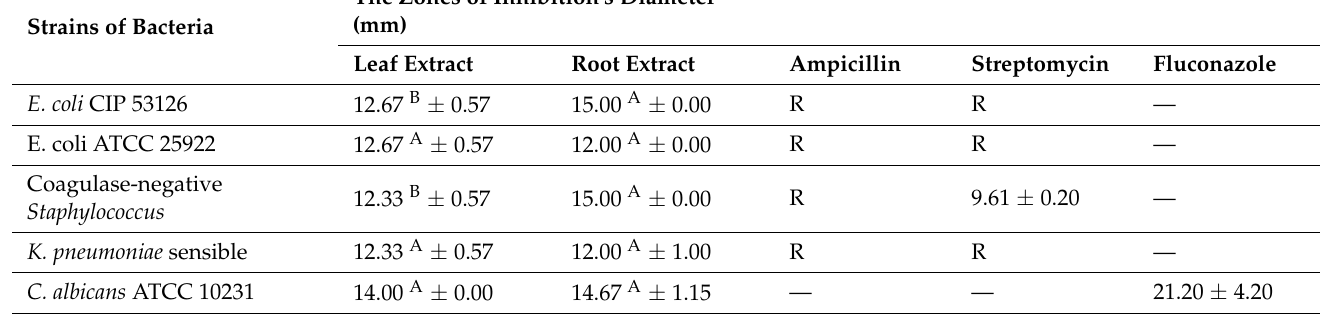
Table 4. DIZ values of the two extracts of C. humilis